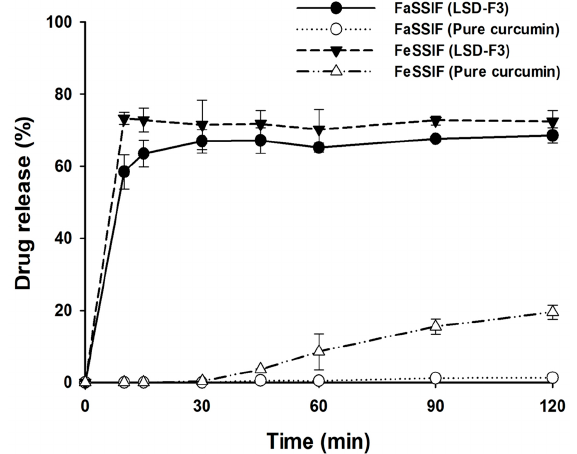
Figure 6. Drug release profiles of LSD-F3 in fasted-state simulated intestinal fluid (FaSSIF) and fed-state simulated intestinal fluid (FeSSIF) (Mean ± SD, n = 3). Table 2. Storage stability of LSD-F3 at 4 ◦ C and 25 ◦ C (Mean ± SD, n = 3).